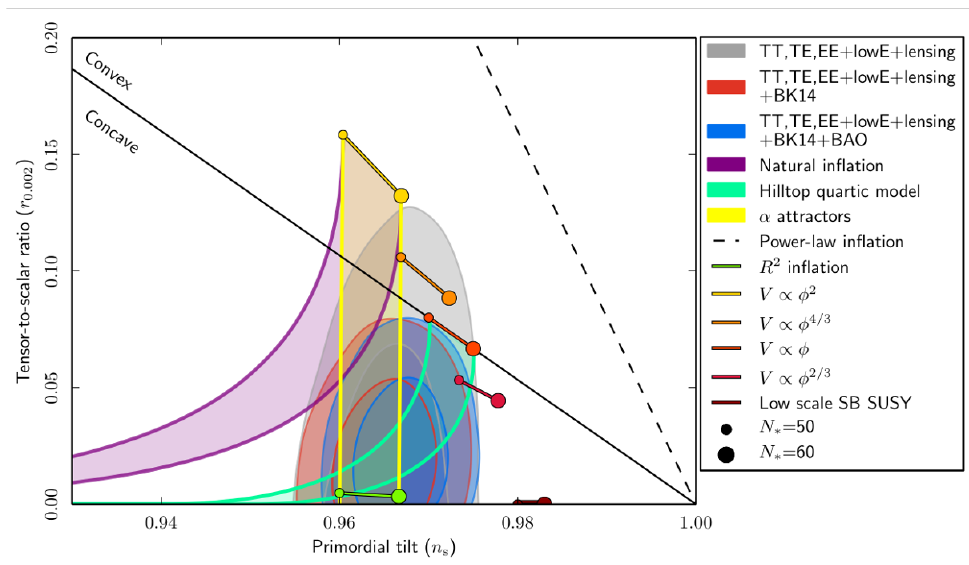
Figure 1 . The results of the Planck 2018 data release. The two yellow lines correspond to (cid:11) - 2 attractors with n s 1 , with the number of e-foldings N e = 50 and N e = N e (cid:25) (cid:0)